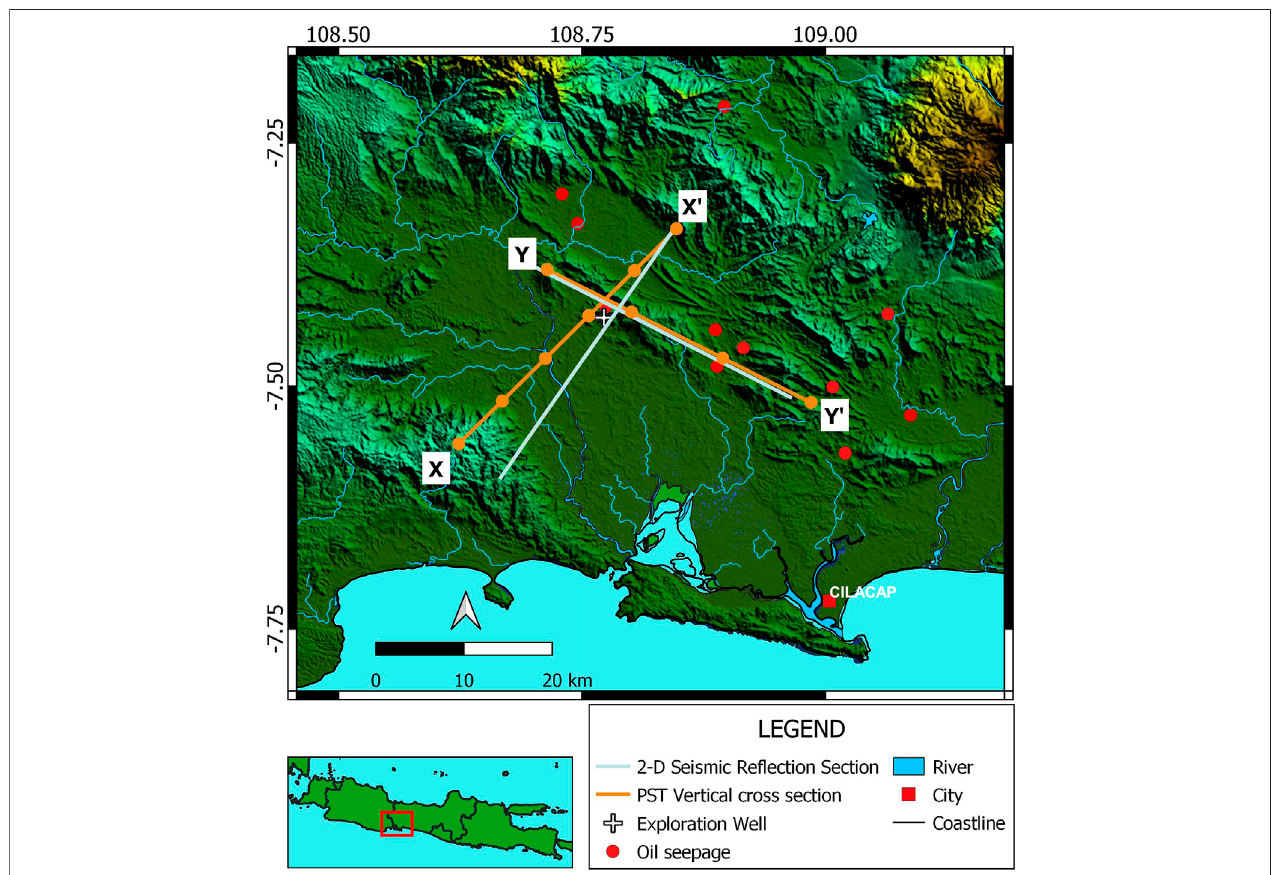
FIGURE 12 | Directions along which the vertical tomographic sections have been compared to 2-D seismic re fl ection sections (Tampubolon et al., 2014).